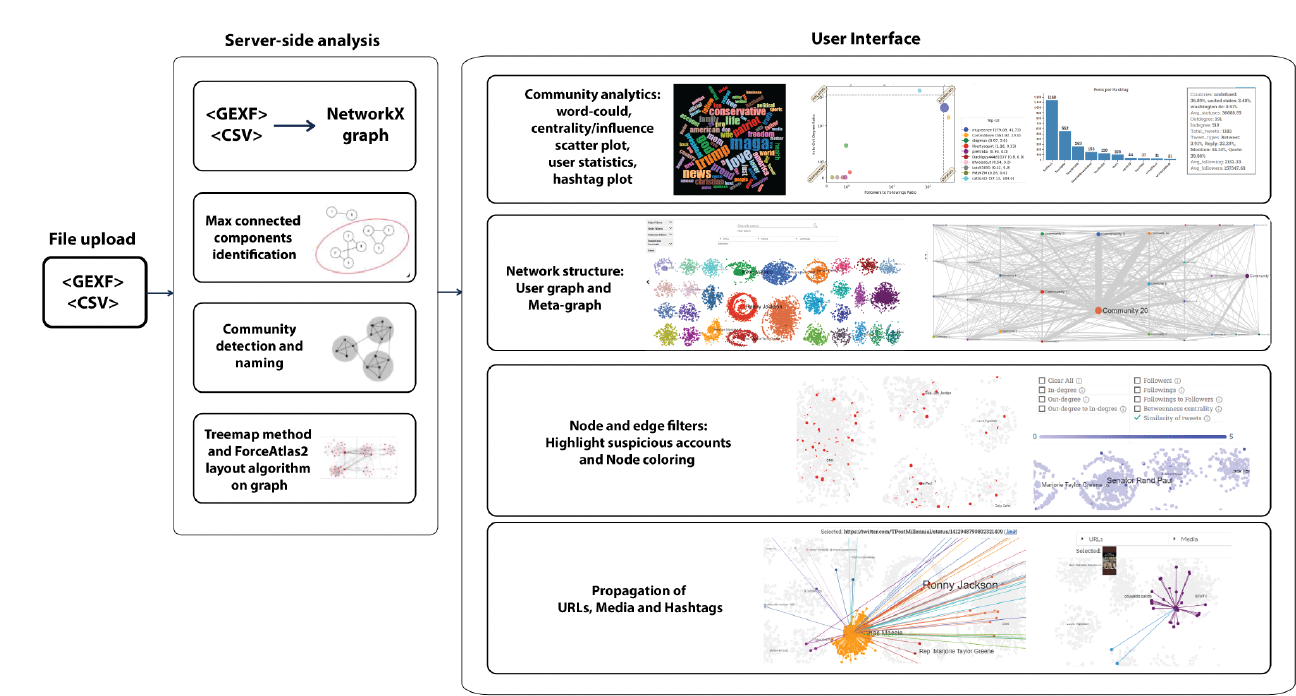
Figure 1. Overview of the MeVer NetworkX